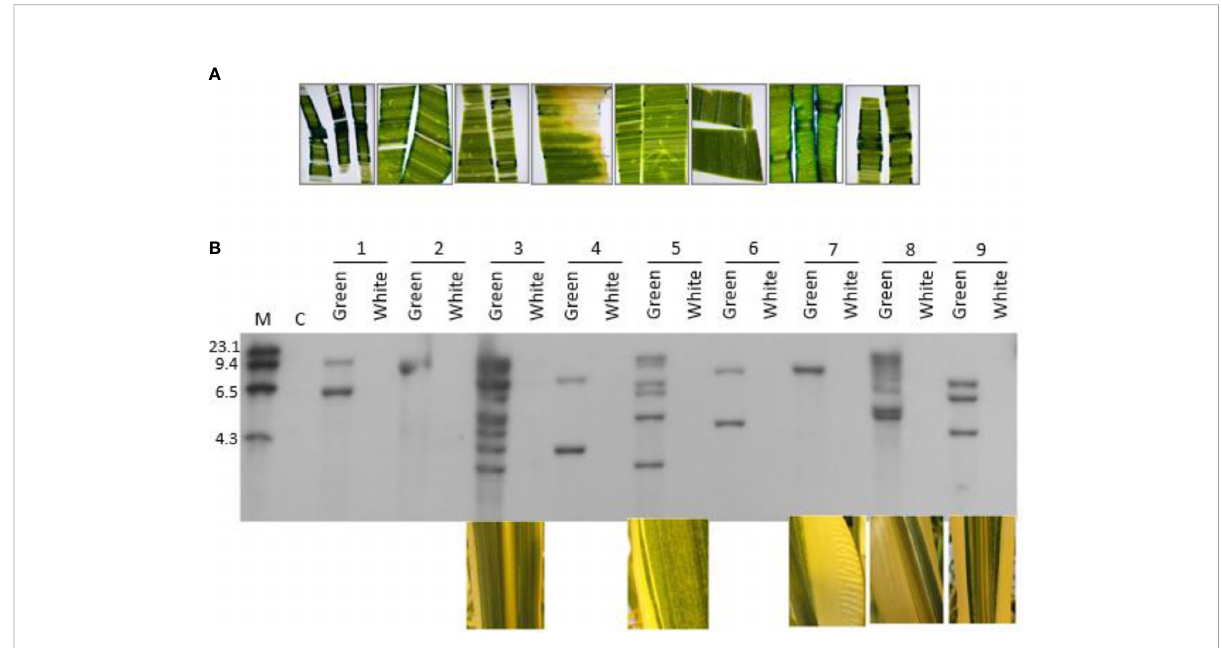
FIGURE 6 Phenotypic and molecular evidence for chimeras in regenerated plants from direct transformation of seed embryos; (A) Non-uniform expression of the gus A gene in leaf tissue from seven independent transgenic events, transformed with pMON97367; (B) Southern blot analysis of nine independent transgenic events. Green and white leaf sectors from individual events were dissected with a scalpel and separated prior to extraction of genomic DNA to test for the presence of transgenic insertions in each sector. Photos of the sectors that were used in the Southern blot experiment are shown below fi ve of the events. M: Molecular marker size ladder. C: Negative control, a non-transgenic plant. Genomic DNA was digested with HindIII and probed with a fragment of the gusA gene. See Supplemental Figure S1 for more